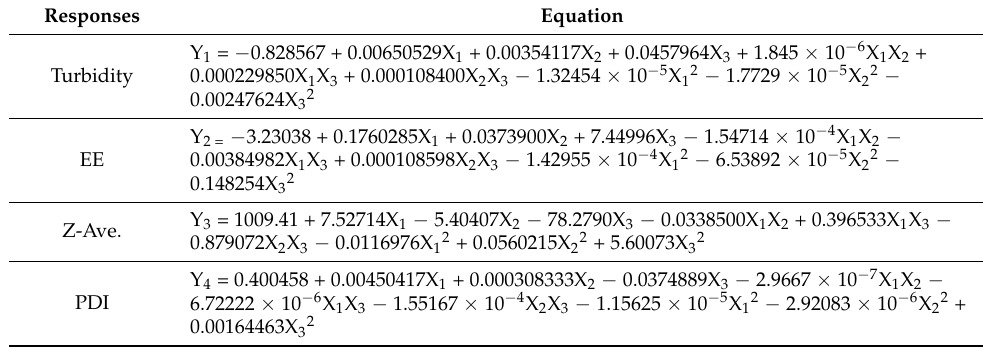
Table 7. The equations of the full quadratic model for each dependent